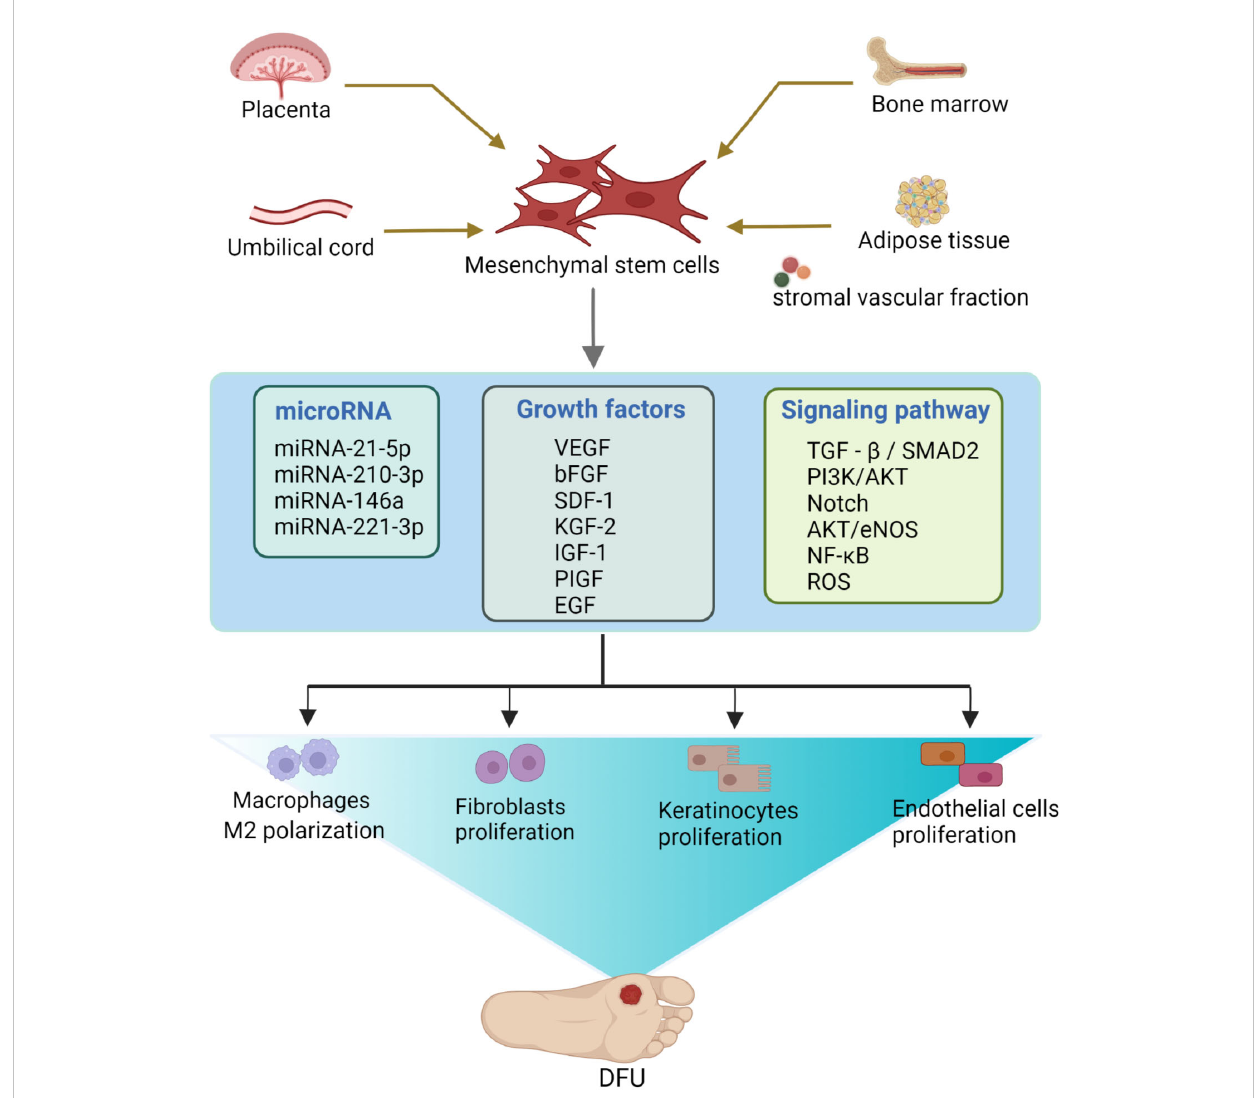
FIGURE 3 The therapeutic mechanism of mesenchymal stem cells (MSCs) for diabetic foot. MSCs are mainly derived from bone marrow, umbilical cord, adipose tissue, placenta, and other parts. During the treatment of diabetic foot, mesenchymal stem cells repair diabetic foot mainly through the proliferation of fi broblasts, keratinocytes and endothelial cells, as well as angiogenesis and polarization of macrophage M2. In this process, paracrine growth factors, related signaling pathways and microRNAs are involved. (Created in